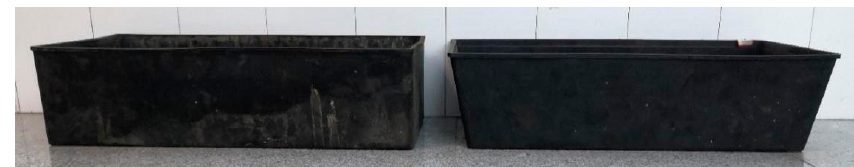
Figure 9. TLVT and ILVT rubber boots.